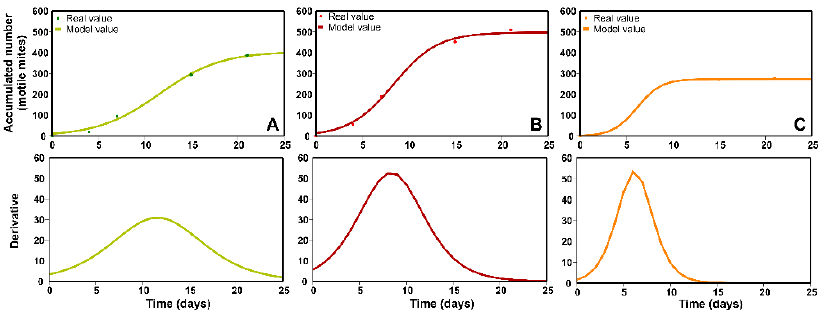
Figure 4. Mathematical model fits (upper panels) to the temporal variation in the total cumulative number of motile mites of the predator Amblyseius swirskii that hatched from the slow-release sa- chets at the following three humidity regimes under laboratory conditions (constant temperature = 25 ± 1 °C) and their derivative functions (lower panels): ( A ) high (87.5 ± 2.5%), ( B ) medium (52.5 ± 2.5%) and ( C ) low RH (22.5 ± 2.5%). The derivative describes the non-cumulative population size. Table 1. Parameters and statistical significance for Verhulst–Pearl logistic functions fitted to the total cumulative number of predatory mites Amblyseius swirskii (motile mites) that hatched from the slow-release sachets in the ambient RH treatment groups (22.5, 52.5 and 87.5%) under laboratory conditions (at a constant temperature = 25 ± 1 ◦ C).